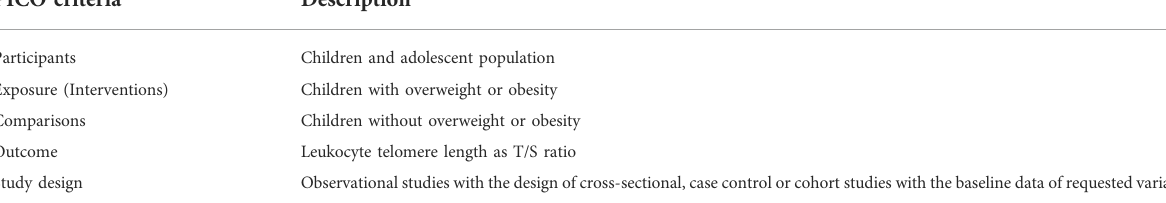
TABLE 1 The PICO criteria used for the systematic